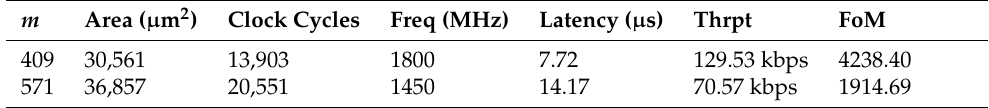
Table 3. Synthesis results on (65 nm)